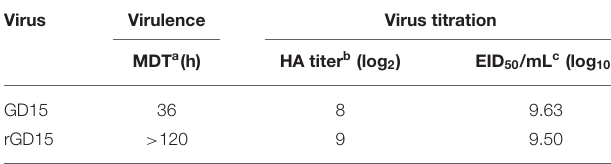
TABLE 1 | Biological characterization of the reassortant H7N9 virus.